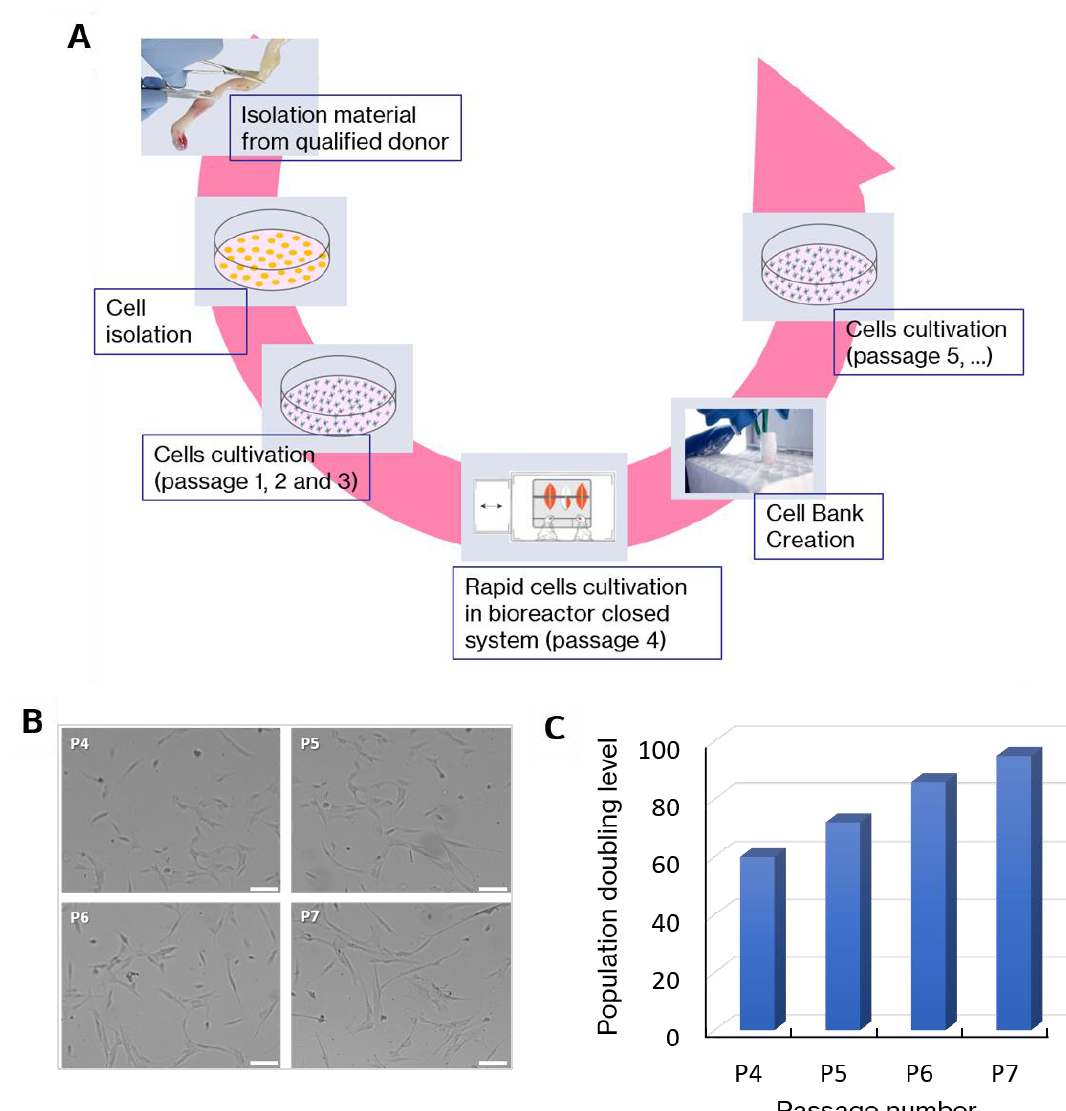
Figure 1. ( A ): The manufacturing process of mesenchymal stem cells—bases of the drug preparation. The steps of in vitro expansion of WJ-MSCs. ( B ): Representative optical microscopy images of WJ-MSCs at four di ff erent stage of in vitro cultivation (P4, P5, P6, P7). Some morphological changes were observed during long-term culture. Scalebar = 100 µ m. ( C ): Population doubling level corresponding to passage number.